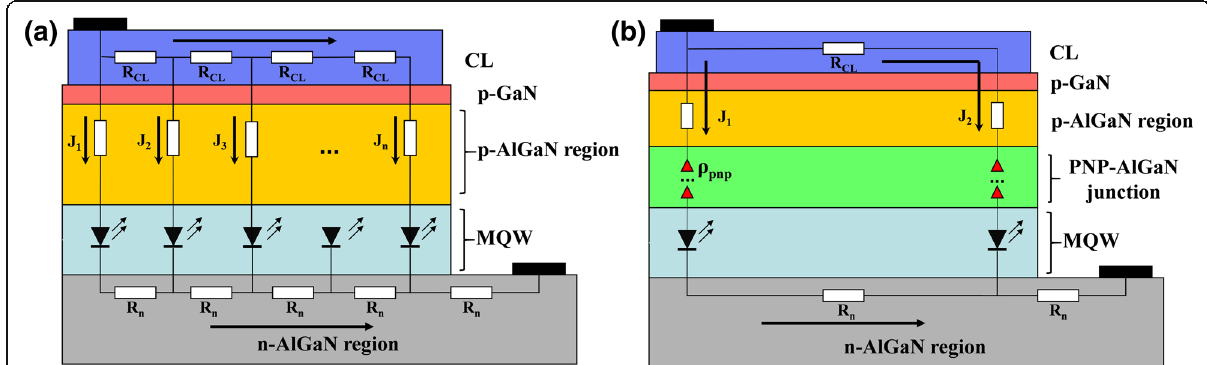
Fig. 2 a Equivalent circuit of DUV LEDs with lateral current-injection scheme ( J 1 > J 2 > J 3 > J 4 > …… > J n ) and b simplified equivalent circuit of the LED with PNP-AlGaN structure, the current paths ( J 1 and J 2 ) are also